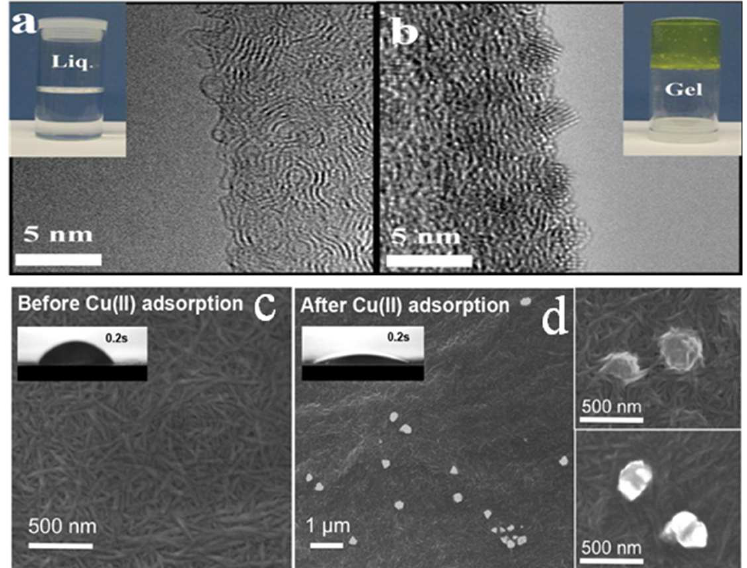
Figure 4. TEM image of ultrafine cellulose nanofibers ( a ) before and ( b ) after adsorption of UO 22+ . SEM image of TOCNF1.5 before ( c ) and after ( d ) Cu 2+ adsorption. Adapted with permission from [47]. Copyright 2019 Elsevier. Adapted with permission from [48]. Copyright 2016 Elsevier.